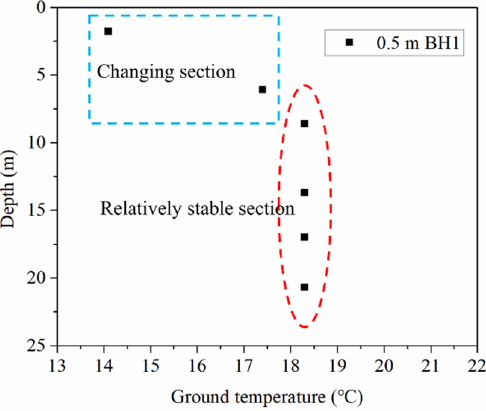
Figure 5. Initial ground temperature distribution with depth in the